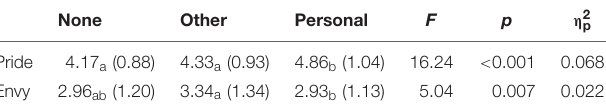
TABLE 2 | Means (and standard deviations) of emotions depending as a function of achievement